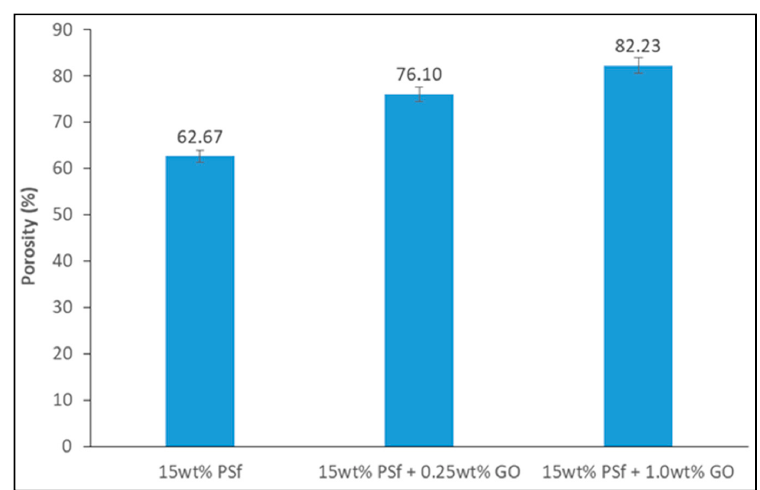
Figure 3. Porosity of the prepared membranes.